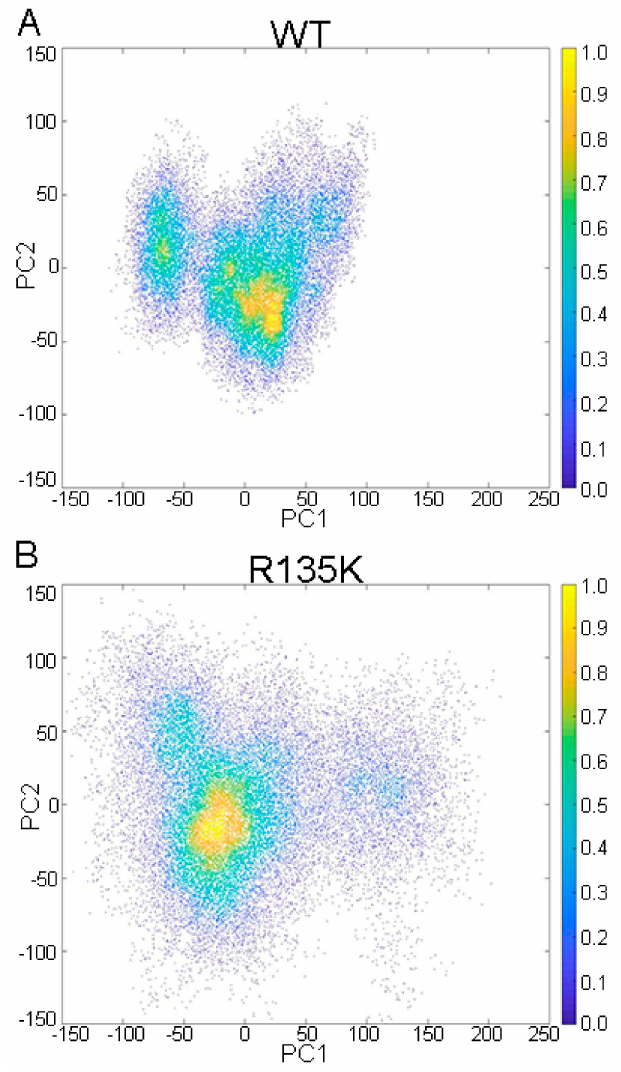
Figure 4. Projections of trajectories of the wild type ( A ) and R135K ( B ) H-Ras–NS1–GDP complexes onto the corresponding first two principal components (PC1 and